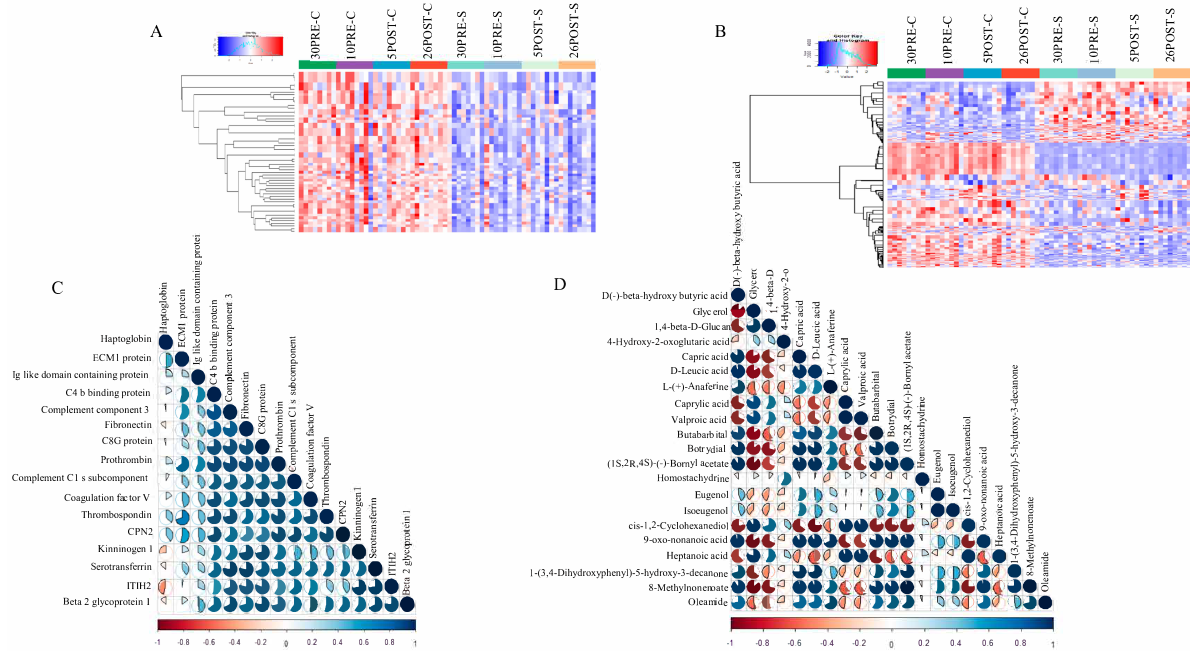
Figure 5. Hierarchical clustering and correlation plots. Intensities for proteins ( A ) and metabolite features ( B ) were z-score- transformed and are displayed as colors ranging from blue to red as shown in the key. The histogram in the key denotes that the distribution of the maximum z scores lies between − 1 and +1. Both rows and columns are clustered using the “Ward.D” hierarchical clustering method and “canberra” distance. ( C ) Correlation analysis was performed using Pearson correlation values among 16 proteins with significant functional roles in NEB. ( D ) Correlation analysis was performed using Pearson correlation values of the top 20 metabolite features with